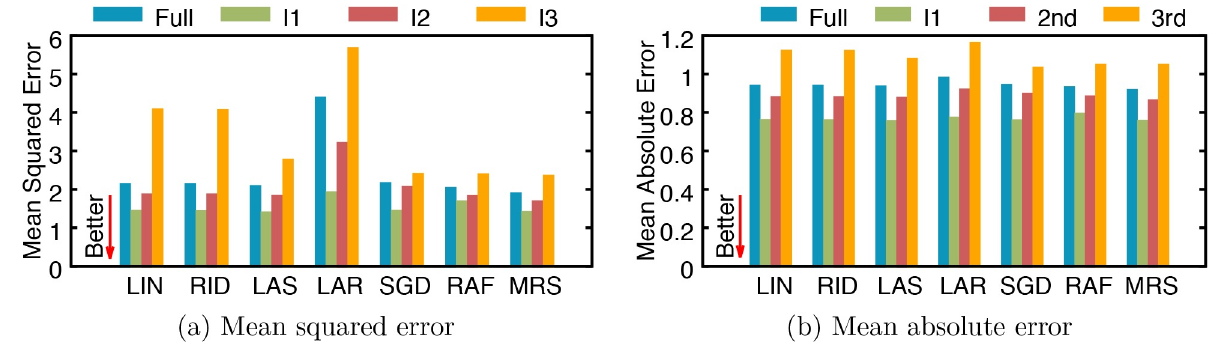
Fig 7. Performance of serum creatinine (SCr) regression by several models trained with the full data and subsets. (a) mean squared error, and (b) mean absolute error. I1: an interval between 2004/1/1 and 2007/11/31, I2: an interval between 2007/12/1 and 2011/10/31, and I3: an interval between 2011/11/1 and 2015/9/30. LIN: linear regression, RID: ridge regression, LAS: lasso, LAR: least-angle regression (LARS), SGD: stochastic gradient descent, RAF: random forest, and MRS: multivariate adaptive regression splines (MARS).